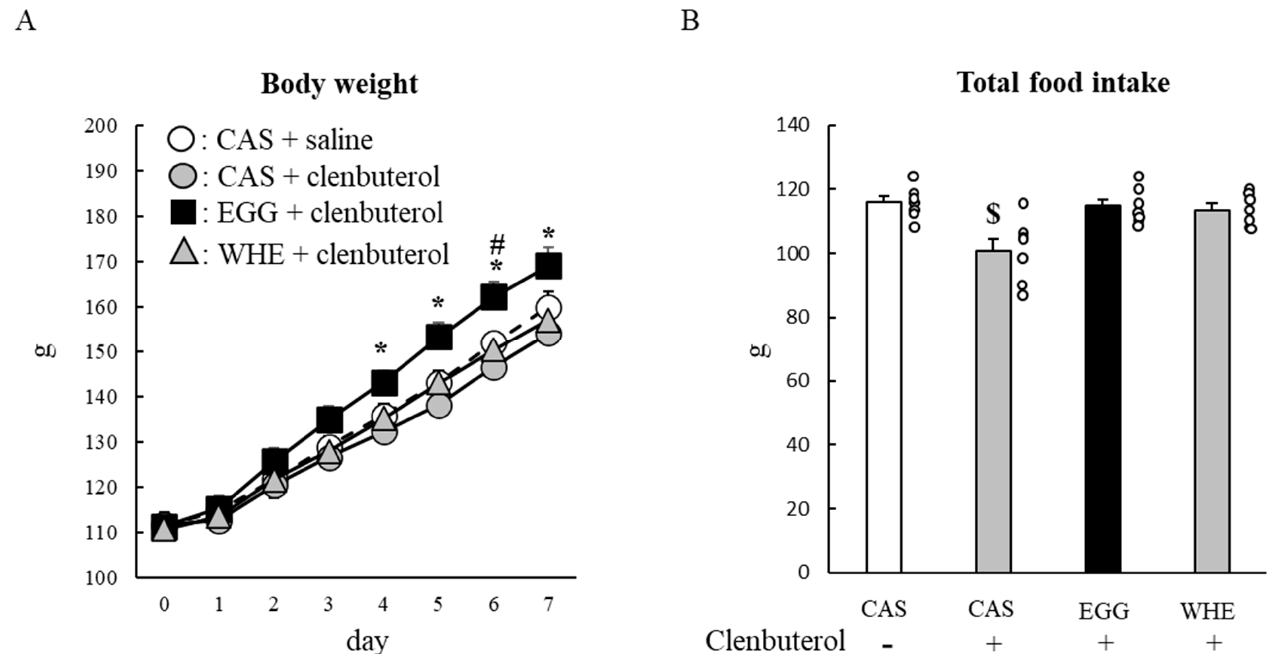
Figure 10. Chronic effect of each protein feeding on body weight and food intake (during 7 days). Rats were assigned to either a casein, egg white, or whey protein diet group, and were maintained under ad libitum feeding for 7 days with or without clenbuterol administration. Bodyweight ( A ) and food intake were measured daily. Total food intake ( B ) was the sum of consumed food during 7 days. The dots beside bars indicate individual value. Values are means ± SE ( n = 7). CAS: casein protein, EGG: egg white protein, WHE: whey protein. *: p < 0.05 vs. CAS+clenbuterol group. #: p < 0.05 vs. WHE+clenbuterol group. $: p < 0.05 vs. other three groups.